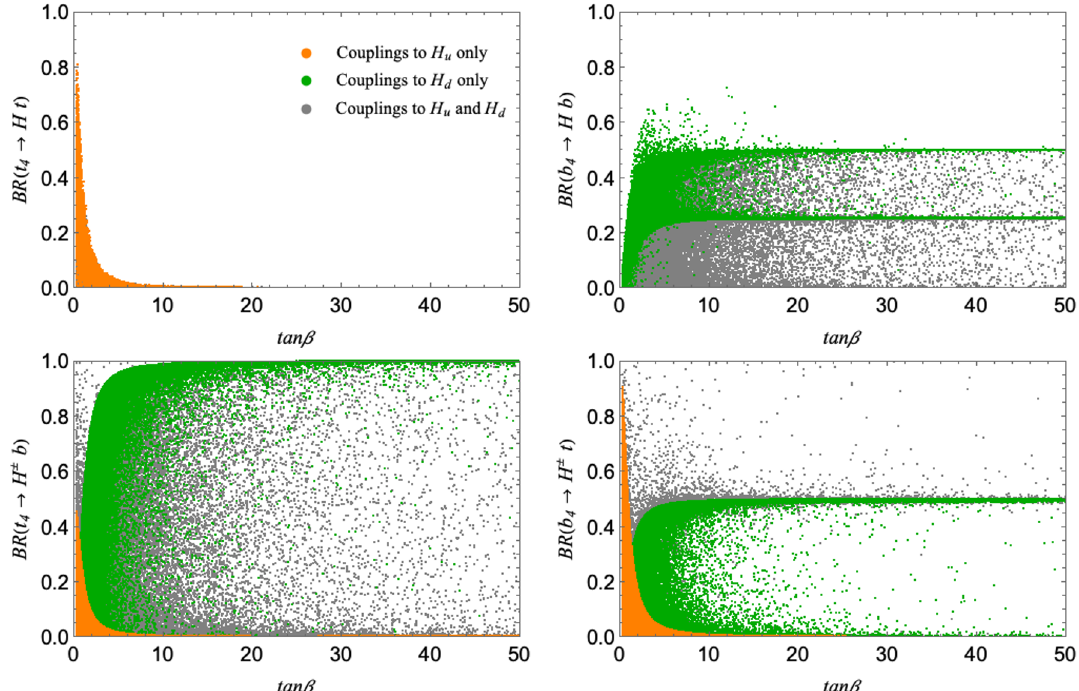
Figure 2 . Allowed branching ratios of t 4 and b 4 into heavy charged and neutral Higgses vs. tan (cid:12) . In all panels, orange (green) points correspond to a parameter scan assuming couplings to H u ( H d ) only; gray points correspond to a parameter scan when all couplings are allowed. In all (cid:12)gures, decay modes through any heavy Higgs boson are allowed and m H = m A = m H (cid:6) = 1 TeV is assumed. Other details of the parameter space scan are the same as in ref.